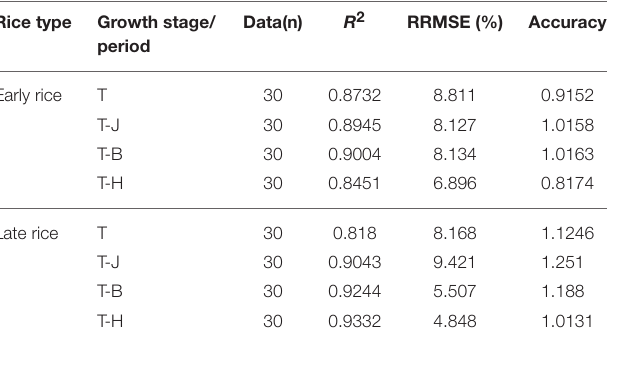
TABLE 5 | The location, variety and parameter of critical N dilution curve for rice grown in different environments.